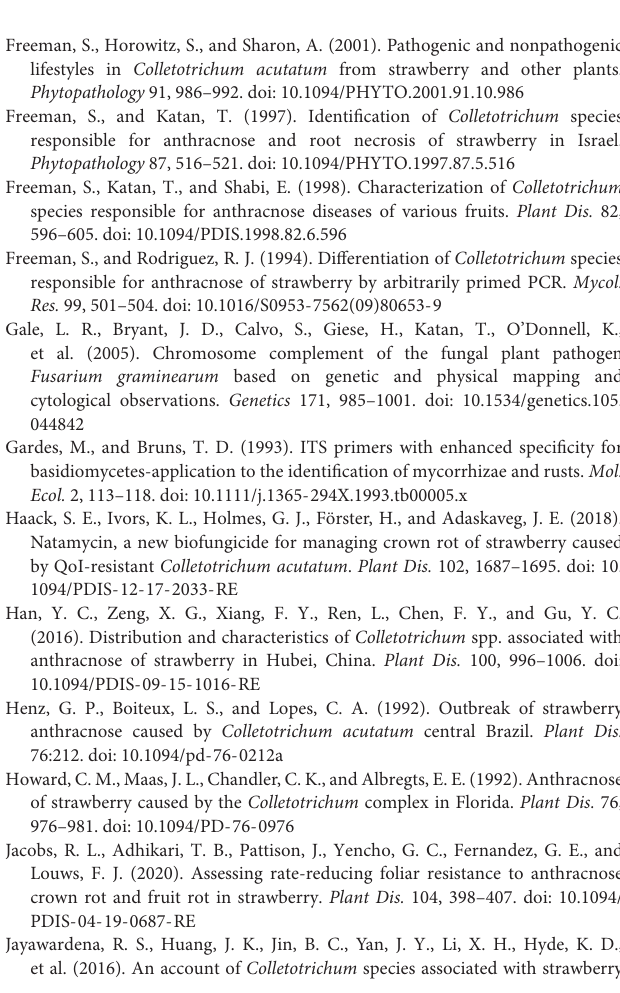
Supplementary Figure 1 | The pathogenicity of CSCR, CFCR, CSLA, CFLA to leaf and crown of different varieties. (A) The pathogenicity of CSCR, CFCR, CSLA, CFLA to leaf of Hongjia, Zhangji, Hongyu, Tianxianzui; W, wounded condition, UW, non-wounded condition. (B) Pathogenicity of CSCR, CFCR, CSLA, CFLA to crown of Hongjia, Zhangji, Tianxianzui under wounded